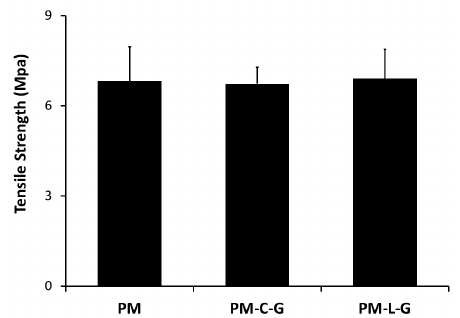
Figure 5. Mechanical properties of PMMA coated and non-coated nanofibers ( n = 15). Tensile strength tested applying 20 N load until breakage was detected.